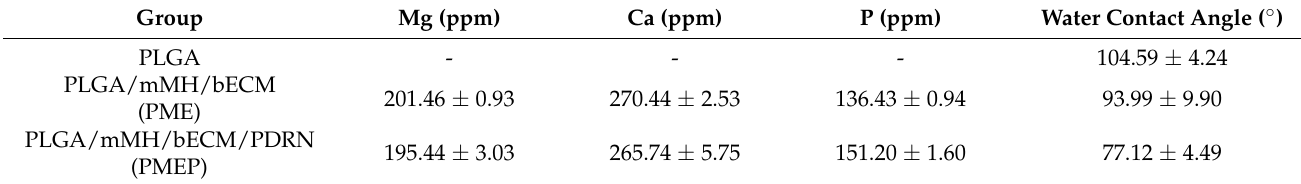
Figure 1. Scaffold characterization. ( A ) representative scanning electron microscopy (SEM) images of PLGA, PLGA/MH/ECM (PME), and PLGA/MH/ECM/PDRN (PMEP) scaffold. (Scale bars = 200 µ m). ( B ) thermal gravi- metric analysis (TGA) thermograms of each scaffold. Change of ( C ) pH and ( D ) mass during in vitro degradation in PBS solution with protease K at 37 ◦ C for 14 days. Table 1. ICP-OES and water contact